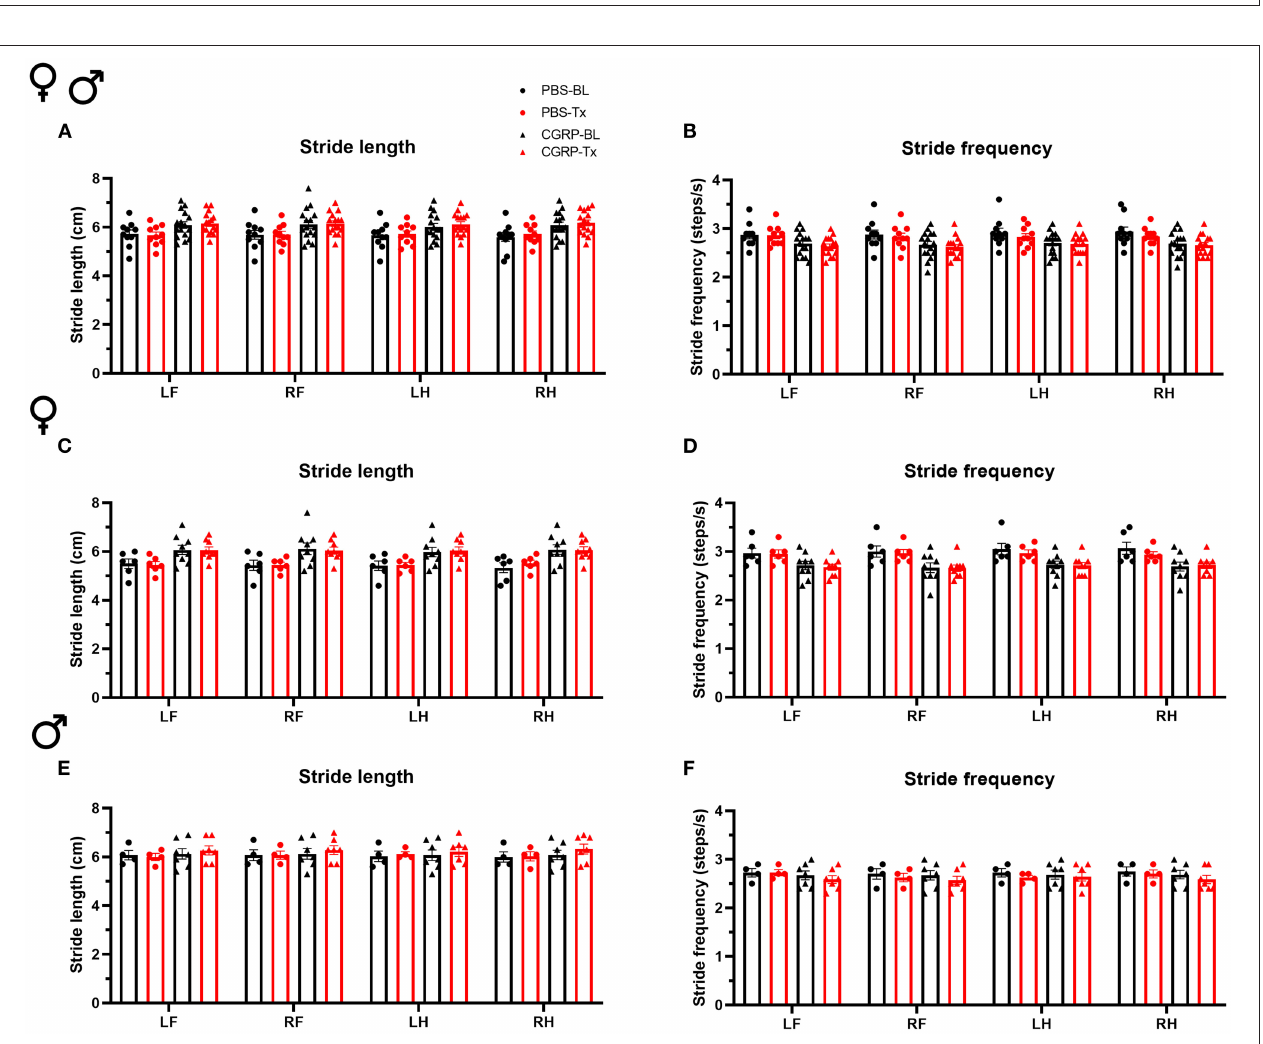
FIGURE 2 | are from two independent experiments. (A) Percentage of time spent resting in the light (upper panel) and dark (lower panel) zones every 5-min block during 30-min light/dark assay for all mice (left), female mice (middle), and male mice (right). All mice in A are further analyzed in B. (B) Mean percentage of time in light (upper panel) and dark (lower panel) zones per 5-min block for individual mice from A. (C) Number of vertical beam breaks per min in light (upper panel) and dark (lower panel) zones every 5-min block during 30-min light/dark assay for all mice (left), female mice (middle), and male mice (right). All mice in C are further analyzed in D. (D) Mean number of vertical beam breaks in light (upper panel) and dark (lower panel) zones per 5-min block for individual mice from C. (E) Number of transitions between light and dark zones every 5-min block during 30-min light/dark assay for all mice (left), female mice (middle), and male mice (right). All mice in E are further analyzed in F. (F) Mean number of transitions between light and dark zones per 5-min block for individual mice from E. Data are the mean ± SEM. Statistics are described in Supplementary Table 1 . * p ≤ 0.05, ** p ≤ 0.01, *** p ≤ 0.001, **** p ≤ 0.0001.